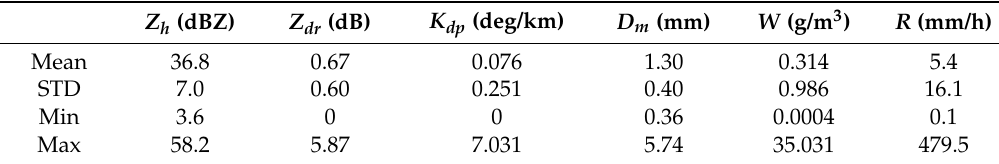
Table 1. Means, standard deviations (STD), minima (min), and maxima (max) for quantities derived from the disdrometer observations. Z h is the radar reflectivity on a logarithmic scale, Z dr is the differential reflectivity on a logarithmic scale, K dp is the specific differential phase, D m is the mass- weighted mean diameter, W is the liquid water content, and R is the rainfall rate at the surface. Note the means and standard deviations of Z h and Z dr are calculated on a linear scale, and then transferred to a logarithmic scale.